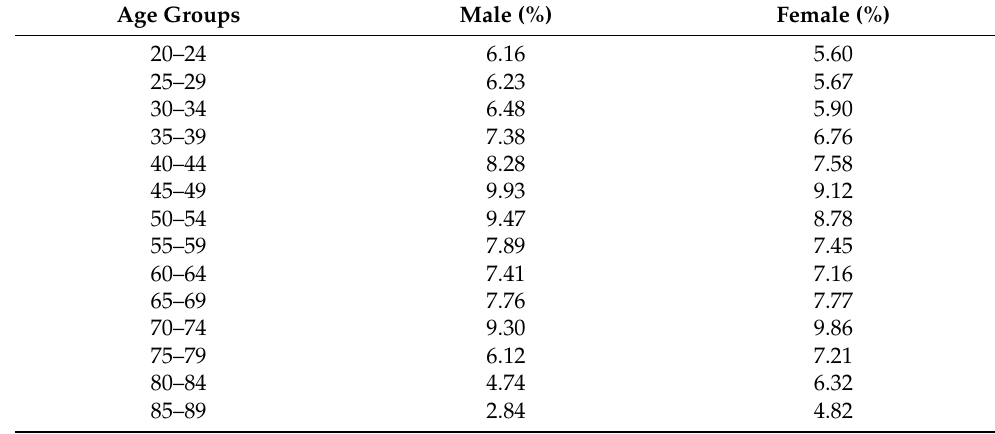
Table A1. Proportion of male and female across different age groups in the 2020 population census. Age Groups Male